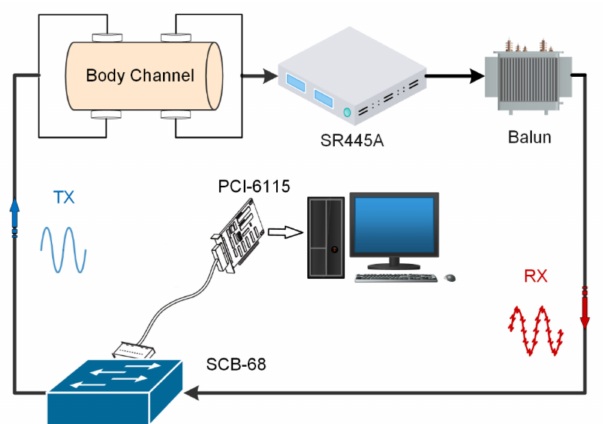
Figure 4. Schematic diagram of experimental platform